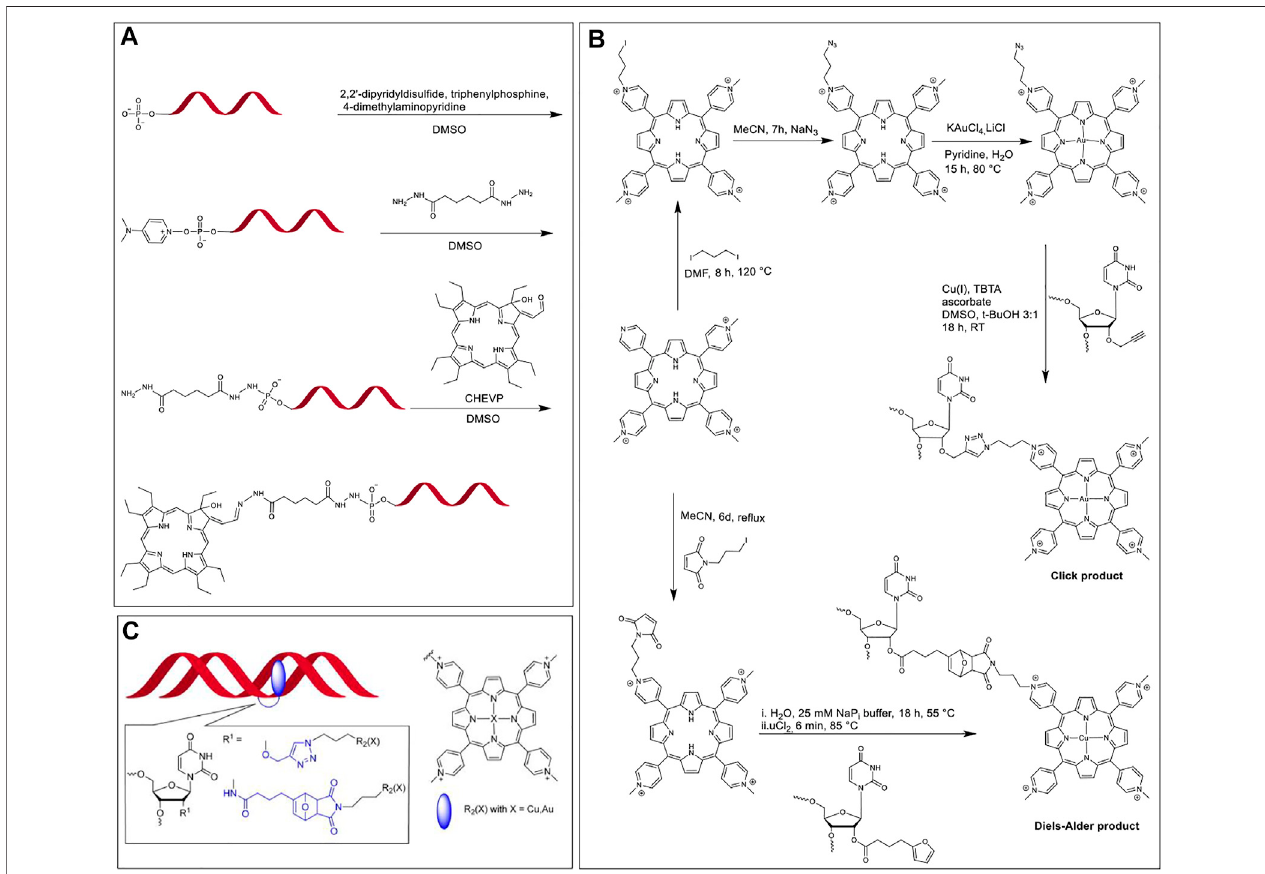
FIGURE 5 | (A) Activation of the 5 ′ -phosphate group of ON and modi fi cation with a dihydrazide linker, followed by the coupling of aldehyde bearing CHEVP with hydrazide modi fi ed ON (Boutorine et al., 1996); (B) Synthesis of modi fi ed TMPP in a multi-step reaction scheme followed by the post-synthetic modi fi cation of ON via CuAAC and Diels-Alder cycloadditions; (C) TMPP (blue) tethered at the 2 ′ -position of modi fi ed uridine intercalating with the DNA duplex. Note; the linker structures are highlighted in blue in the inset. Adapted with permission from (Wellner and Wagenknecht, 2014).